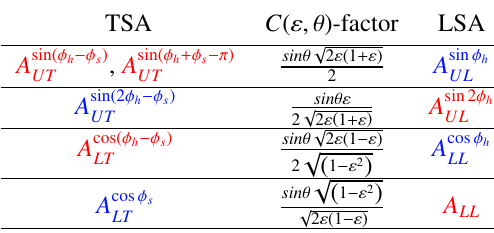
Table 2. Mixed "T" and "L" amplitudes and C ( ε,θ )-factors TSA C ( ε, θ )-factor LSA